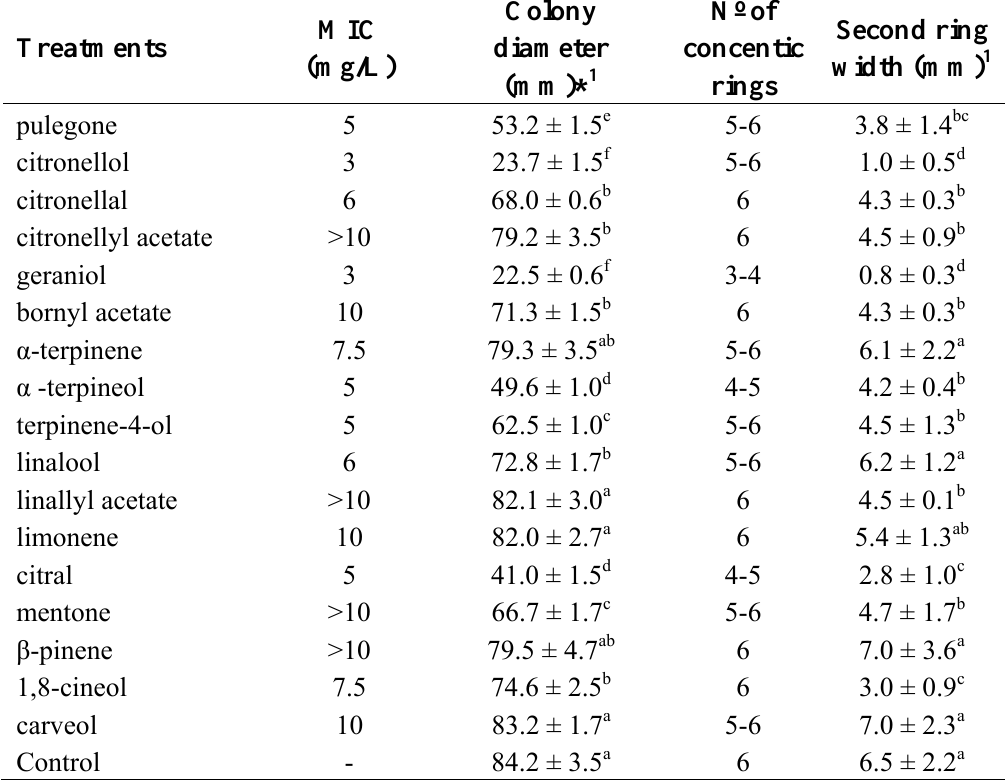
Table 1. Minimum inhibitory concentration (MIC) and the effect of 1/10 MIC concentration of monoterpenes on the swimming/swarming behavior of P. mirabilis